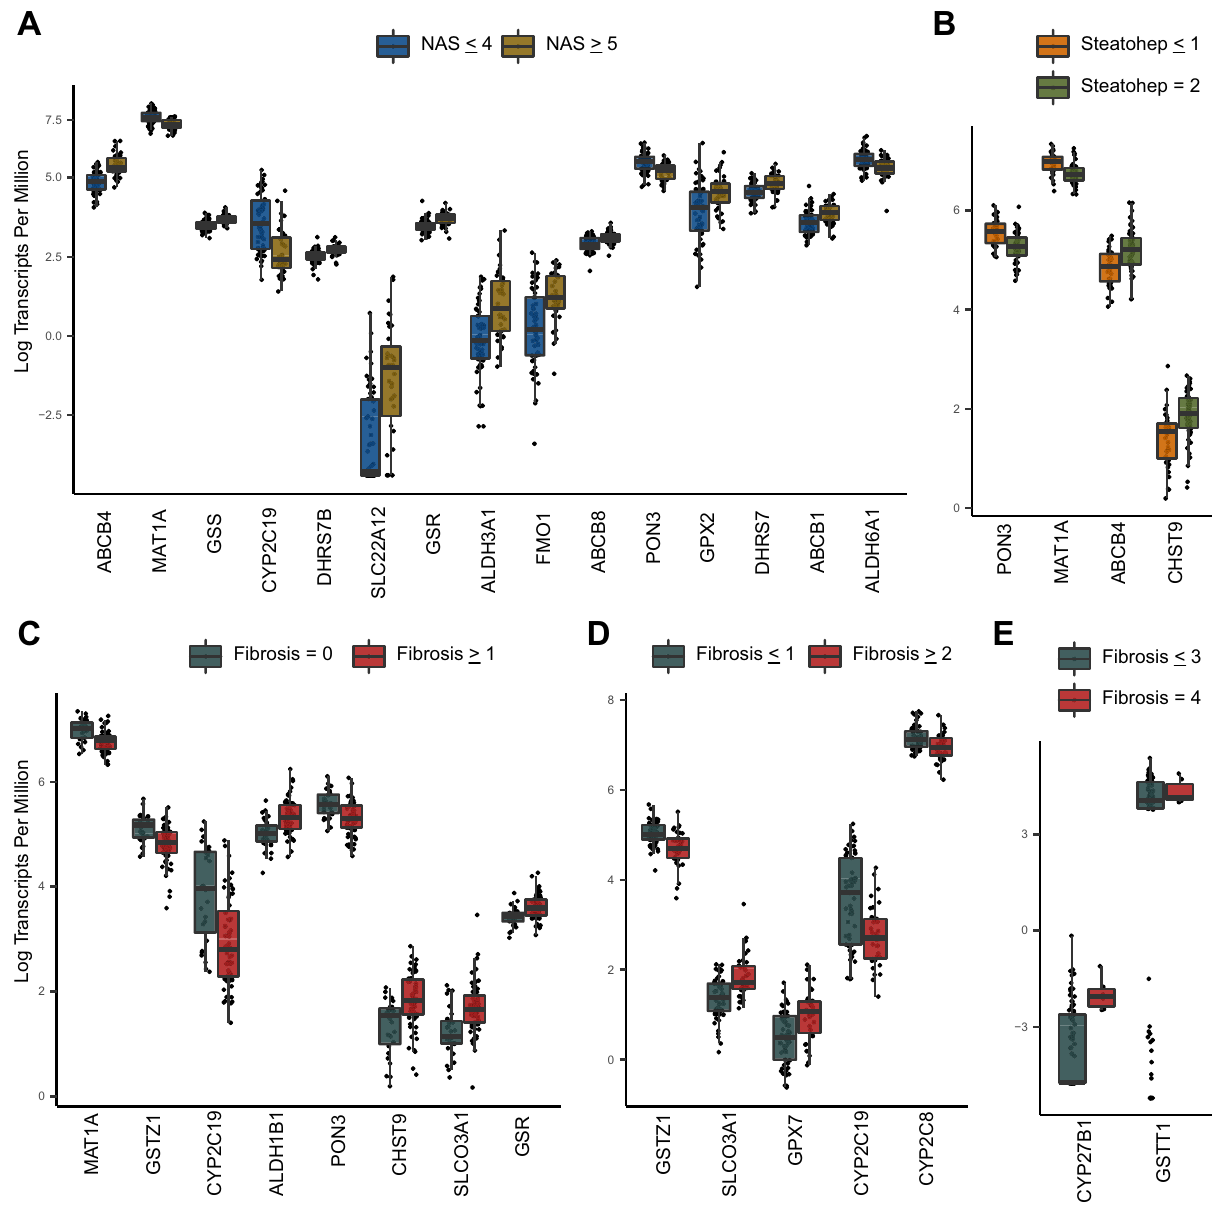
Fig. 2 | Boxplots showing Bonferroni-adjusted signi fi cant t-test results. Differ- ences are based on two-sided Welches t-tests. The x-axis is ordered from left to right by p -value. All p -values in this fi gure are below 0.0002. Standard boxplot features (lower quartile, median, upper quartile) are used as de fi ned by ggplot2